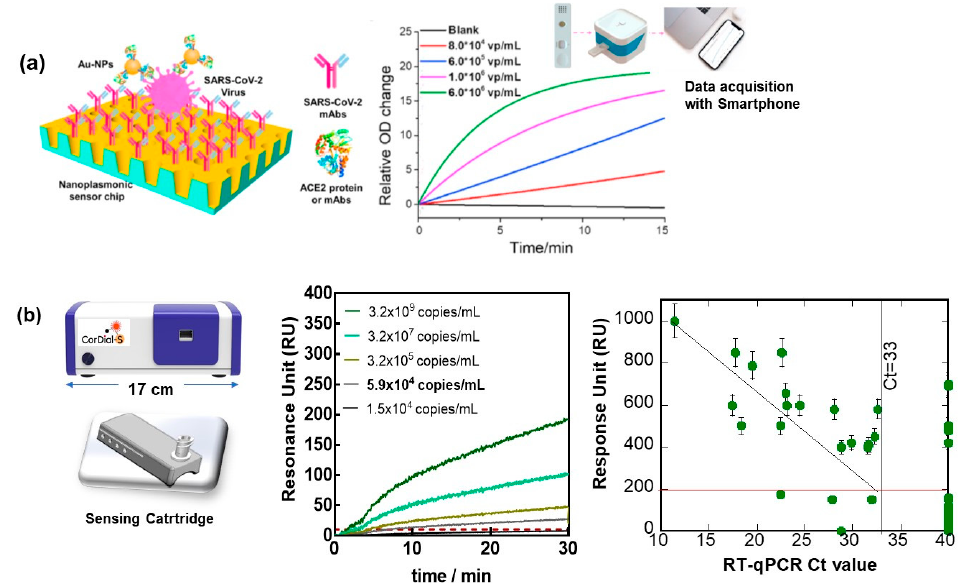
Figure 5. Portable SPR concepts applied to SARS-CoV-2 sensing: ( a ) Principle of nanoplasmonic resonance sensor for the detection of SARS-CoV-2 viral particles in a sandwich assay together with a photo of the developed sensor chip cartridge to be inserted into a handheld device with smartphone for data read out and binding curve to different SARS-CoV-2 pseudoviral particles concentrations (Reprinted with permission of Ref. [50], 2021, Elsevier).( b ) (left) Image of a desk-top SPR POC testing device with cartridge-based sensing ability. (middle) SPR sensograms upon flowing cultured SARS-CoV-2 viral particles over cartridge-based SPR chip modified with VHH-72-Fc (Figure 4b), running buffer HBS-P + 1 × containing 0.01 M HEPES, 0.15 M NaCl and 0.05% v / v Surfactant P20 as well as a correlation between RT-qPCR positive (50) and negative (69) nasopharyngeal samples and SPR data. Cut-off between positive and negative was 186 RIU (red line).